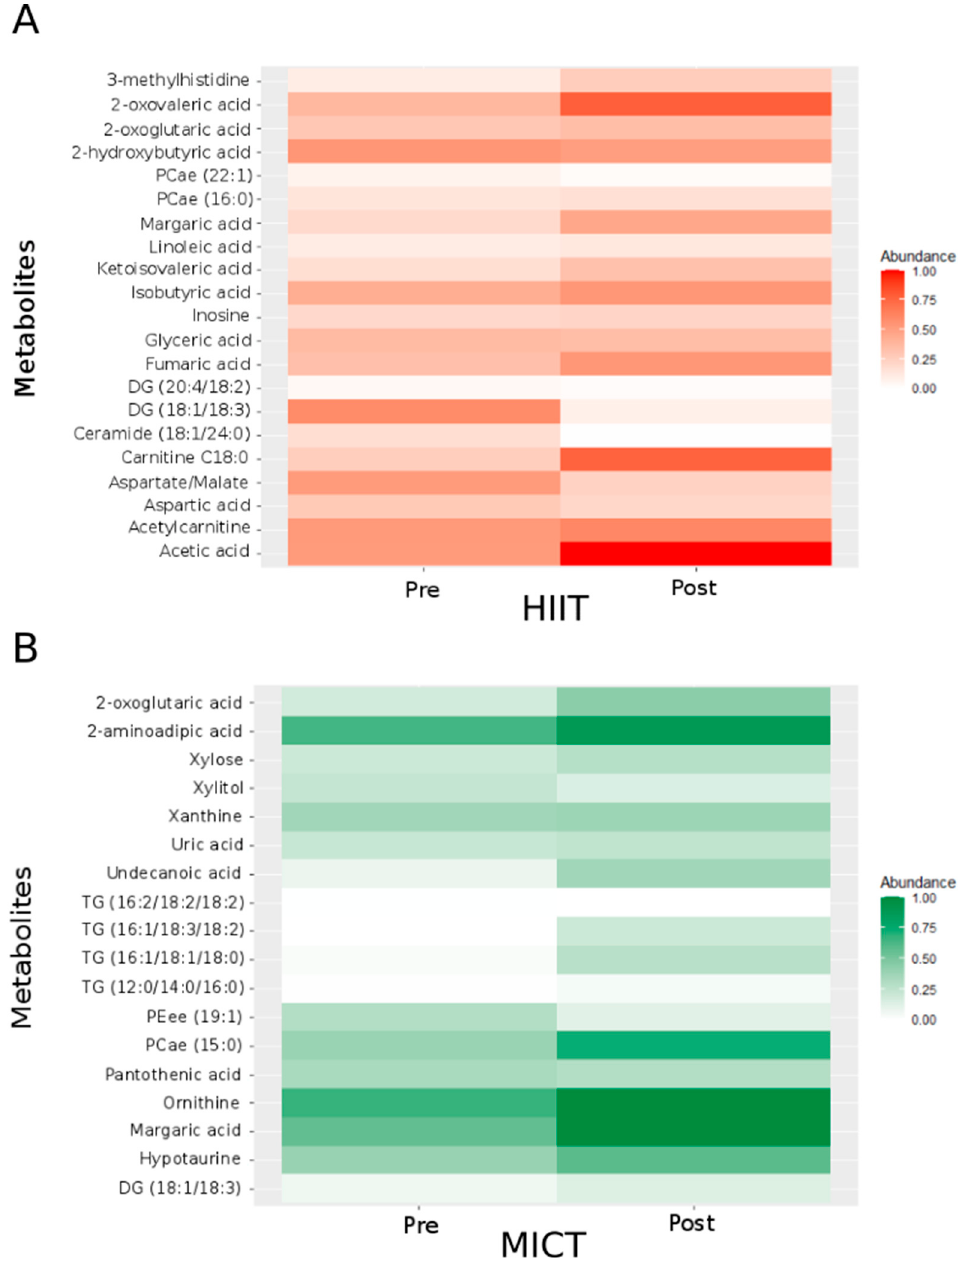
Figure 2. Heatmap showing the normalized abundance of the metabolites and ratios of metabolites with significant HIIT effect ( A ) and MICT effect ( B ). For normalization, each metabolite’s minimal value was subtracted from all values and divided by the highest value. Pre: before the 12 ‐ week intervention. Post: after the 12 ‐ week intervention. PCae: acyl ‐ alkyl ‐ phosphatidylcholine; DG: Diglyceride; TG: Triglyceride; PEee: ether ‐ phosphatidylethanolamine; PCae: acyl ‐ alkyl ‐ phosphatidylcholine; / = ratio.